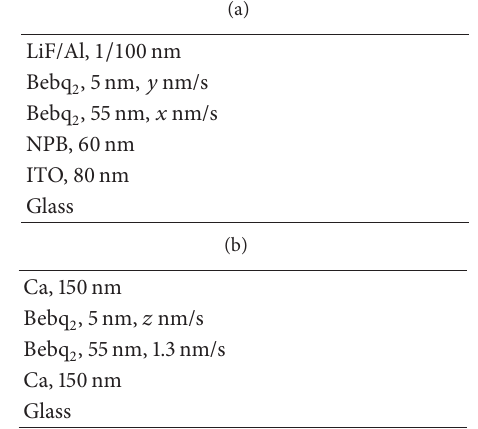
Table 1: (a) Five different device structures used to investigate the dependence of device performance on deposition rate of ultrathin ETL. Consider ( 𝑥 , 𝑦 ) = (1.3, 0.03), (1.3, 0.3), (1.3, 1.3), (0.3, 0.3), and (0.03, 0.03) for devices A, B, C, D, and E, respectively. (b) Three different device structures used to investigate the electron injection characteristics on deposition rate of ultrathin ETL. Consider 𝑧 = 0.03 , 0.3, and 1.3 for devices F, G, and H,